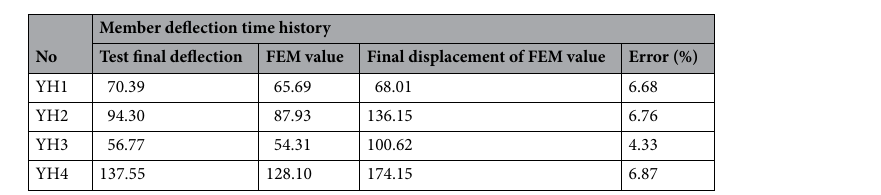
Test Value − FEM Value Test Value .